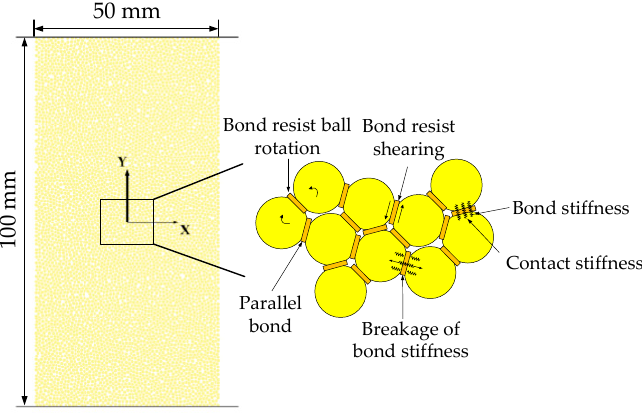
Figure 1. Bonded − particle models.